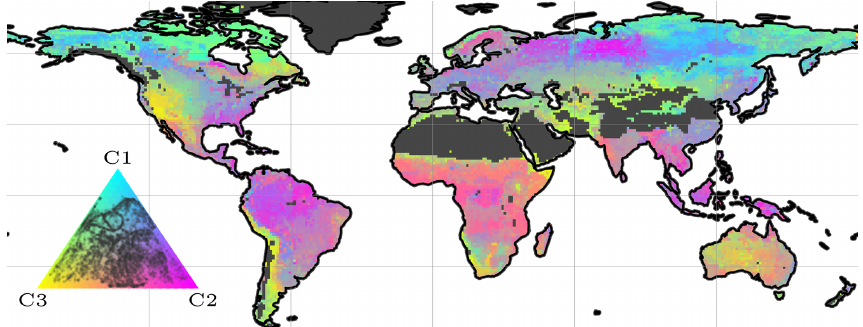
Figure C2. The t-distributed stochastic neighbor (t-SNE) reduction to three dimensions (C1–3) of static variable encoding (originally 12 dimensions; ρ enc in Fig. 1) of one cross-validation run. The encoding is a low-level representation of the static inputs, i.e., soil and land- cover properties, learned by a neural network. The inset ternary plots show the distribution of the map